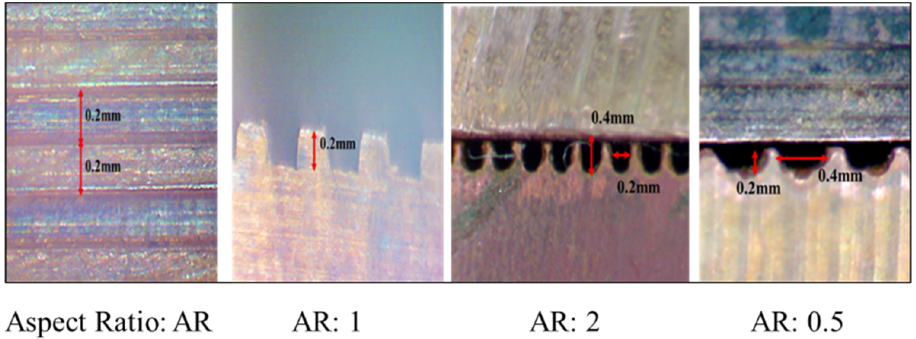
Figure 3. The constructed microchannel at various aspect ratios was used in the present research.